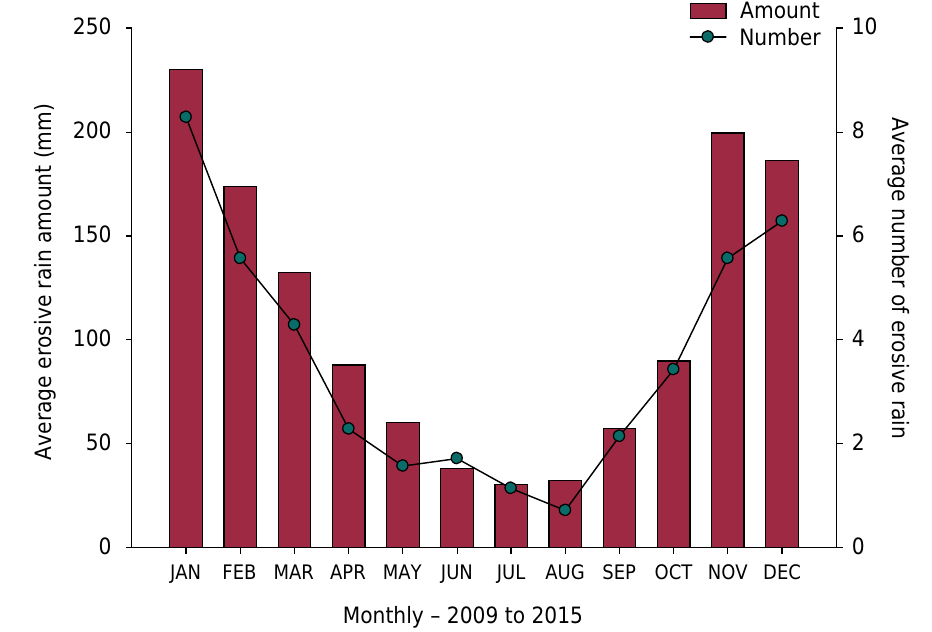
Figure 2. Average monthly rainfall amount of erosive events, and average number of erosive rains, from 2009 to 2015, at Pirassununga, state of São Paulo,